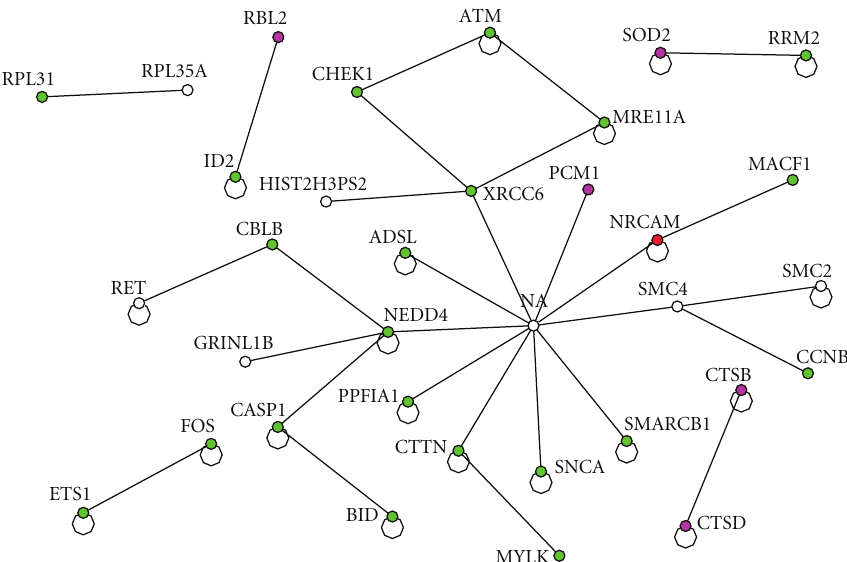
Figure 4: The interaction between the top 14 up regulated genes from Table 1 with the set of important genes based on network topology (Table 3). The red one represents the gene from Table 1. The green colored ones are down regulated and the red and purple ones are up regulated.